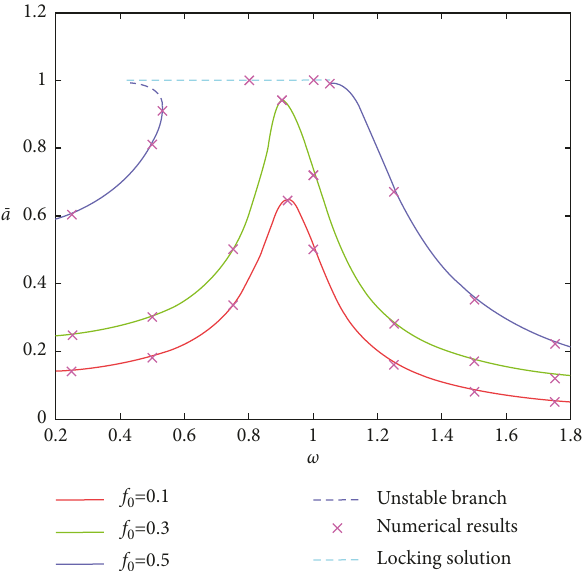
Figure 3: Variation of the amplitude of periodic solutions with the frequency of the excitation when α � 0 .